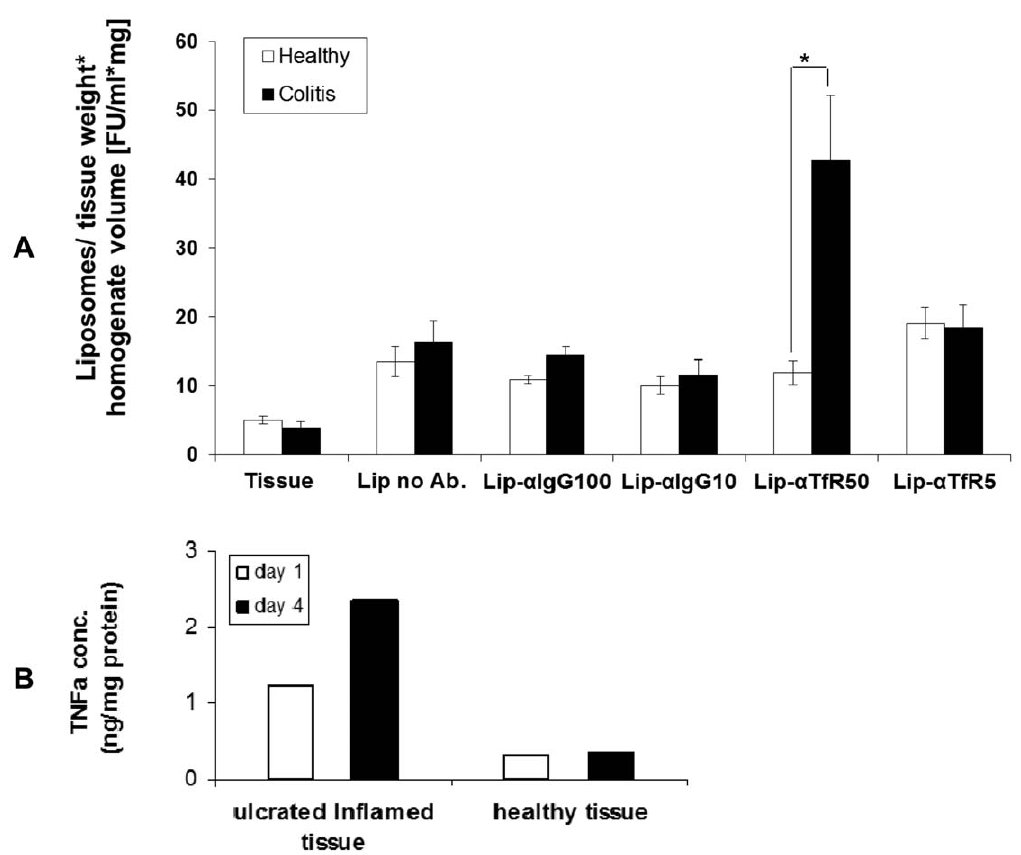
Figure 10. Anti-TfR immunoliposomes adhere preferentially to inflamed mucosa. (A) Ex vivo adherence of two formulation bearing anti- TfR antibody (‘‘Lip- a TfR5 ‘‘ and ‘‘lip- a TfR50’’ respectively), two negative control formulations, bearing non-specific antibody (‘‘Lip- a IgG10’’ and ‘‘Lip- a IgG100’’ respectively) and naked liposomes (no antibody, ‘‘lip no Ab’’) to everted gut-sacs taken from DNBS-treated or vehicle treated rats. Shown are the averages of 3 independent experiments 6 S.E.M. * P-value , 0.05 was obtained by t- test. (B) TNF a levels analyzed by ELISA of inflamed and non-inflamed homogenate tissue obtained from experimental induced colitis one or four days after colitis induction.